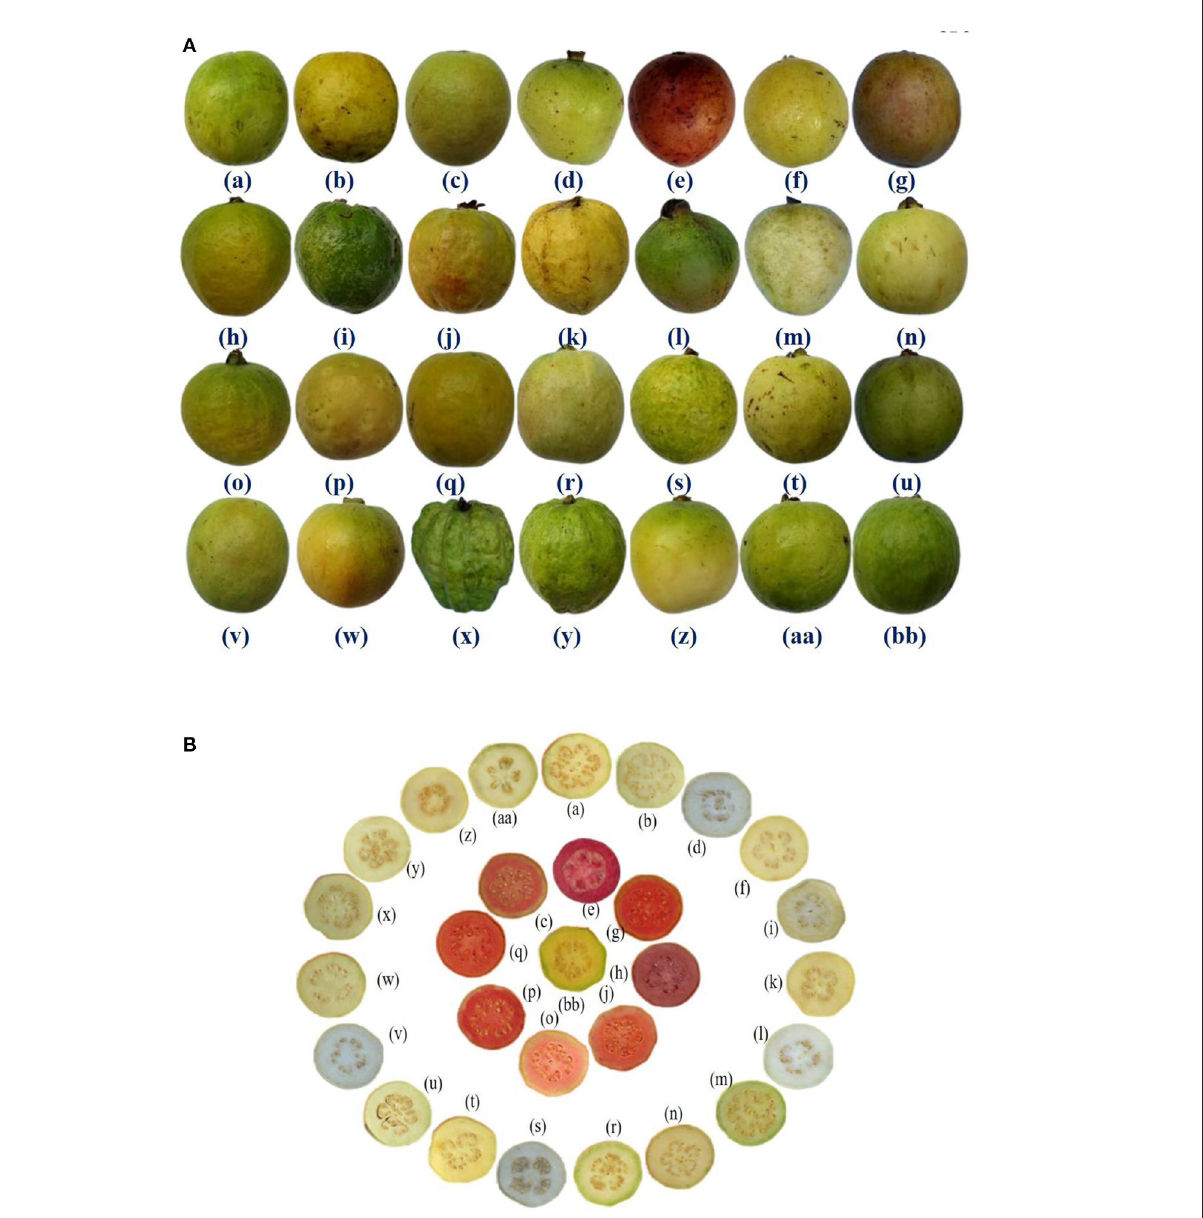
FIGURE1 (A) Fruit morphology of 28 guava germplasm selected for study. (B) Transverse section of fruits of 28 guava germplasm selected for study. (a) Allahabad Safeda, (b) Allahabad Safeda variant, (c) Arka Kiran, (d) Arka Mridula, (e) Black guava (f) Hisar Safeda, (g) Hisar Surkha, (h) Hisar Surkha variant, (i) Kasipur collection, (j) Lalit, (k) Lucknow-49, (l) P. friedrichsthalianum, (m) P. pumilum, (n) Pant Prabhat, (o) Punjab Pink, (p) Red type I, (q) Red type II, (r) Sasni, (s) Sasri, (t) Shweta, (u) Snow White, (v) Soft Seeded variant, (w) Sour type, (x) Thai, (y) Thai variant, (z) Trichy, (aa) VNR & (bb) Yellow